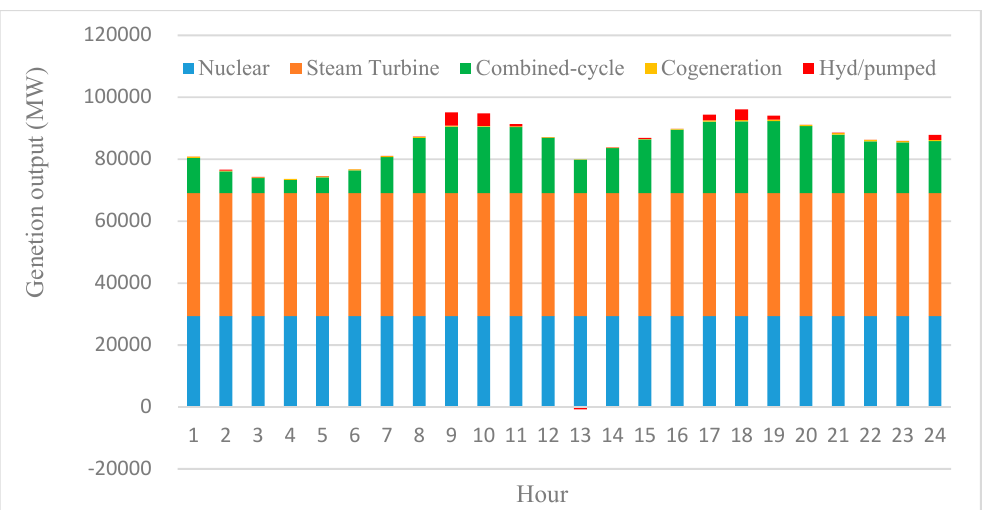
Figure 5. Generation schedule on the peak day in 2029.